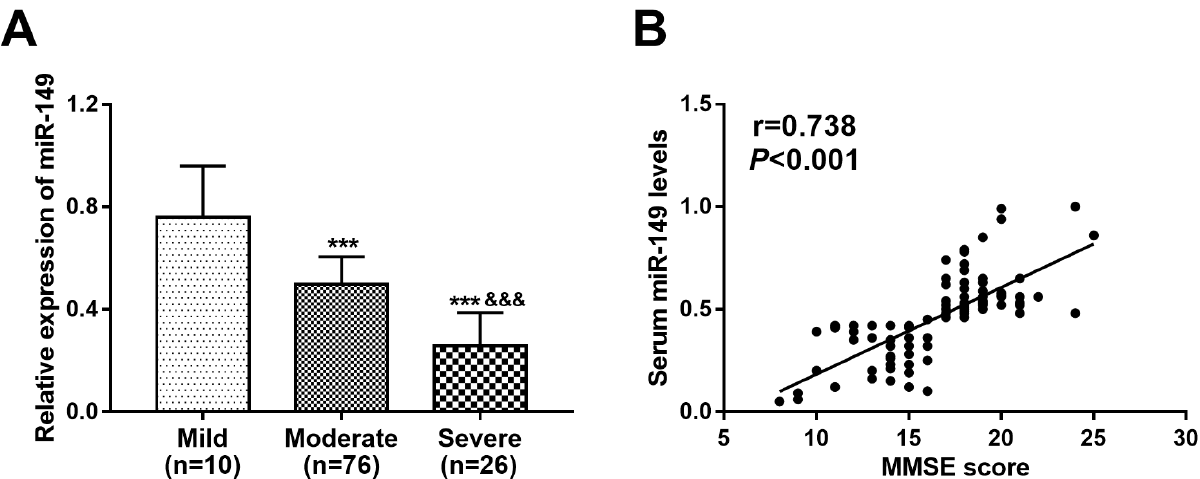
Figure 2 - Expression of miR-149 in AD patients with different degree of dementia and its correlation with MMSE scores of AD patients. A . Expression of miR-149 was decreased as disease severity increased. B . A positive correlation between miR-149 and MMSE score (r = 0.738, P < 0.001). *** P < 0.001 vs. Mild; &&& P < 0.001 vs.